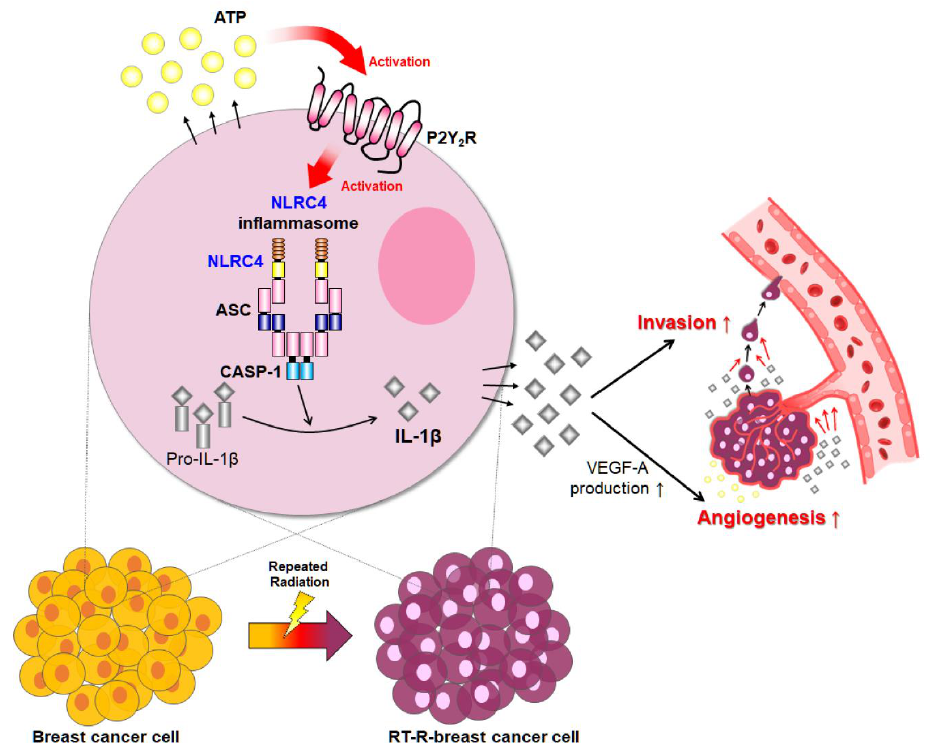
Figure 5. Schematic representation of the proposed role of P2Y 2 R in the regulation of the NLRC4 inflammasome and cancer cell progression in MDA-MB-231 and RT-R-MDA-MB-231 cells.